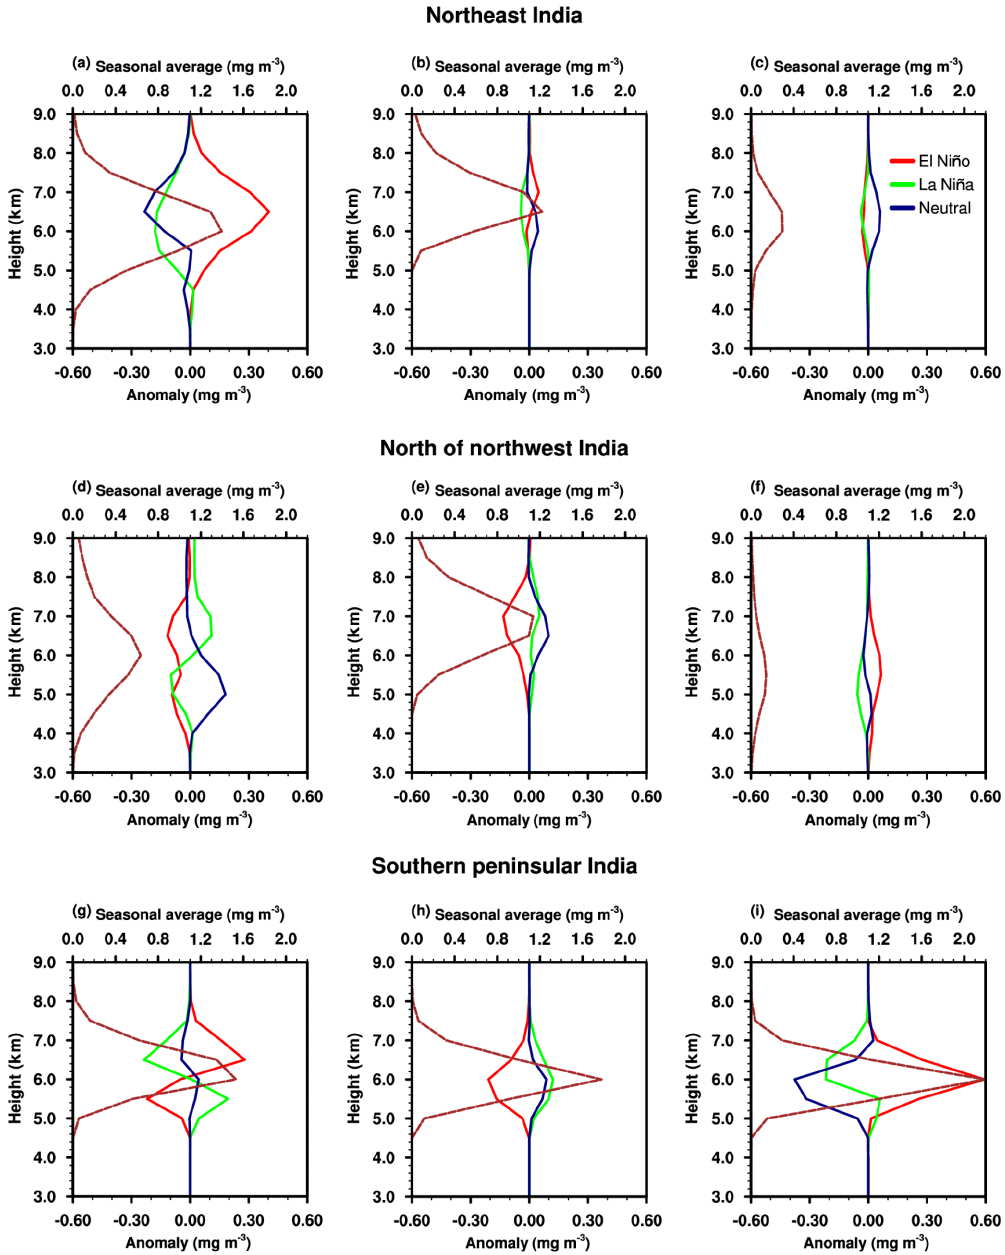
Figure 5. Seasonal average (brown dotted curve) and anomaly composite of graupel concentration during different ENSO phases. (a, d, g) Premonsoon season. (b, e, h) Monsoon season. (c, f, i) Postmonsoon